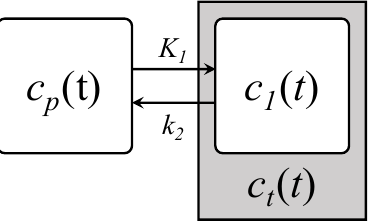
Figure 1. One-tissue compartment model (1TCM) describing the tracer transport from blood to tissues. c p ( t ) and c 1 ( t ) are, respectively, the tracer concentration in the blood and tissue compartment and K 1 and k 2 are the associated transport rate